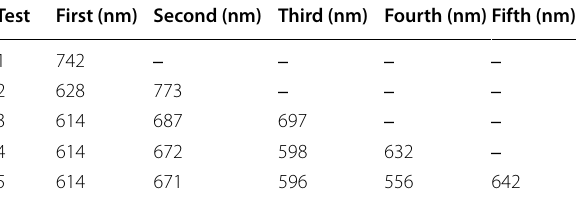
Table 1 Depth variation of each indentation during the one array indentations with the rotation angle of 0° and the spacing of 1 μm